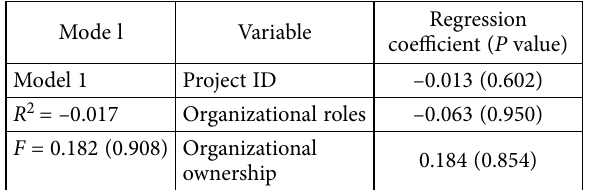
Table 3. Reliability analysis results